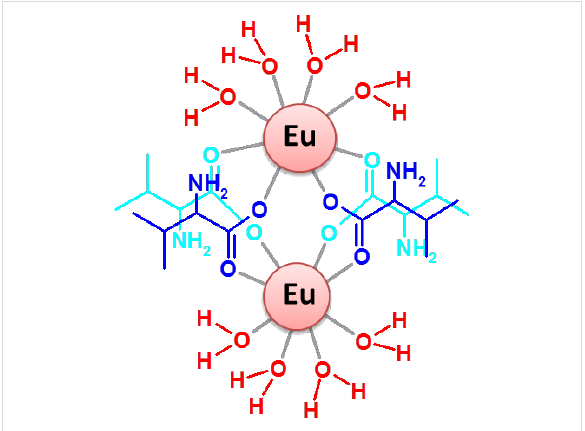
Figure 12: Schematic representation of a L-valine-europium